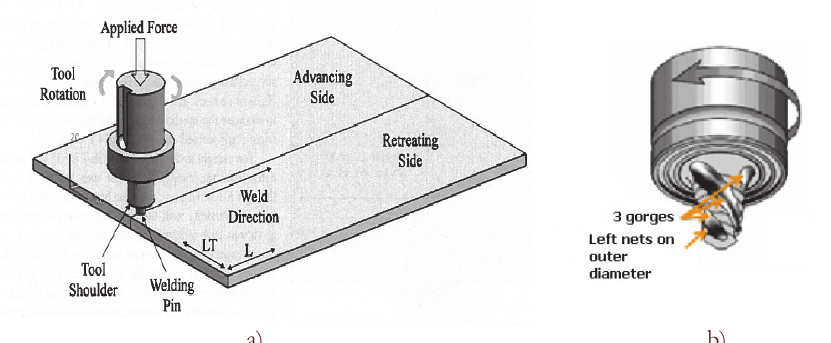
Figure 1: FSW welding principle. a) FSW welding process, [8]. b) FSW welding tool,